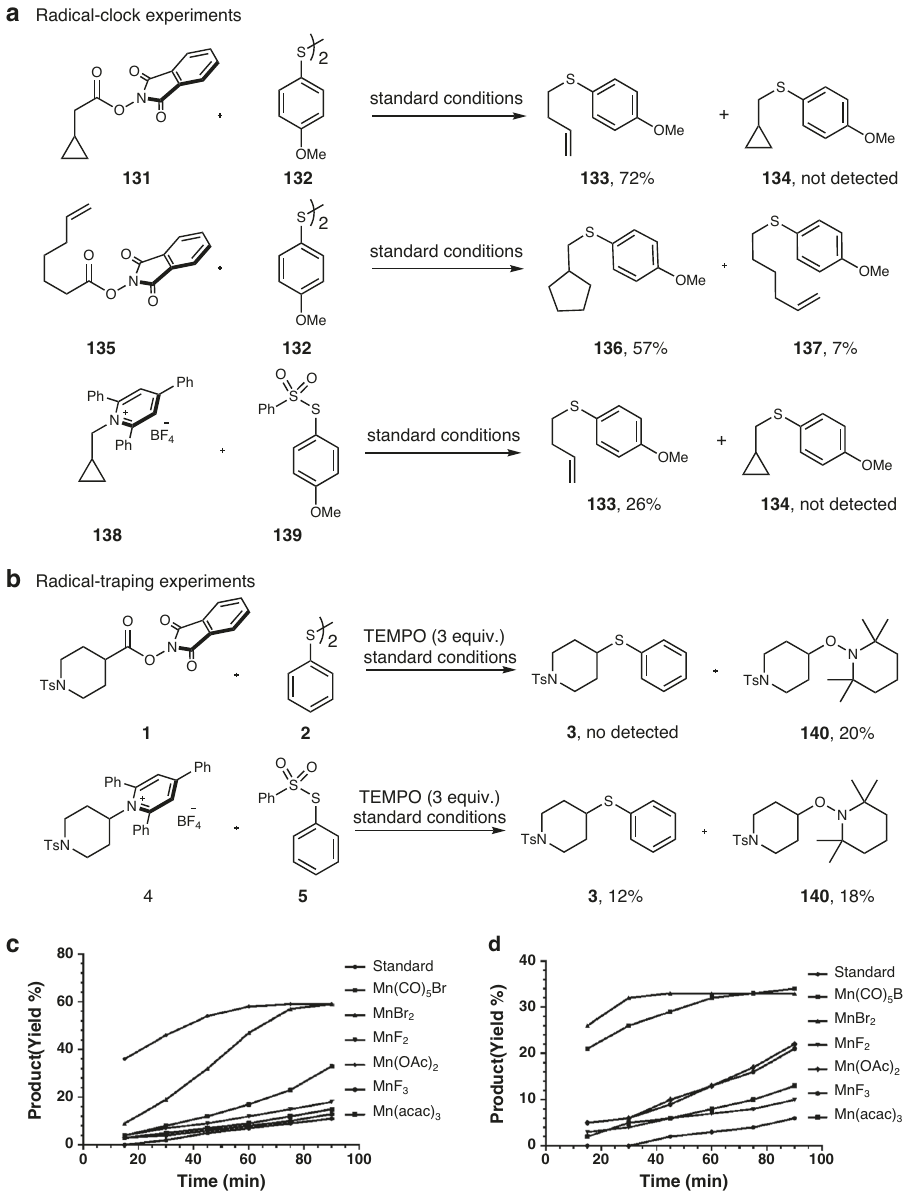
Fig. 10 Mechanistic studies. a Radical-clock experiments. b Radical-traping experiments. c Kinetic analysis of decarboxylative thiolation. d Kinetic analysis of deaminative